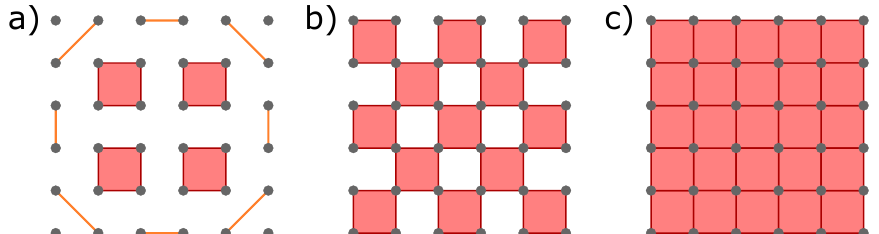
Figure 1: Three spin-1 / 2 models on the square lattice with ring-exchange interaction of the form S + S − S + S − on the red solid plaquettes. The model (a) has been proposed in Ref. [ 57 ] and shown to exhibit the SSPT phase that is equivalent to a HOTI. The ring-exchange is present on every fourth plaquette, while at the edges the pairwise interaction is XY ( S + S − ), as shown with orange lines. The model (b), where the ring-exchange dynamics is allowed for every second plaquette, is an equivalent rep- resentation of the QLM (or, to be precise, its kinetic part), as well as the fully packed QDM if considered in a particular charge sector. The XY-plaquette model (c) is a natural continuation of this sequence, that enables ring-exchange dynamics on every plaquette of the square